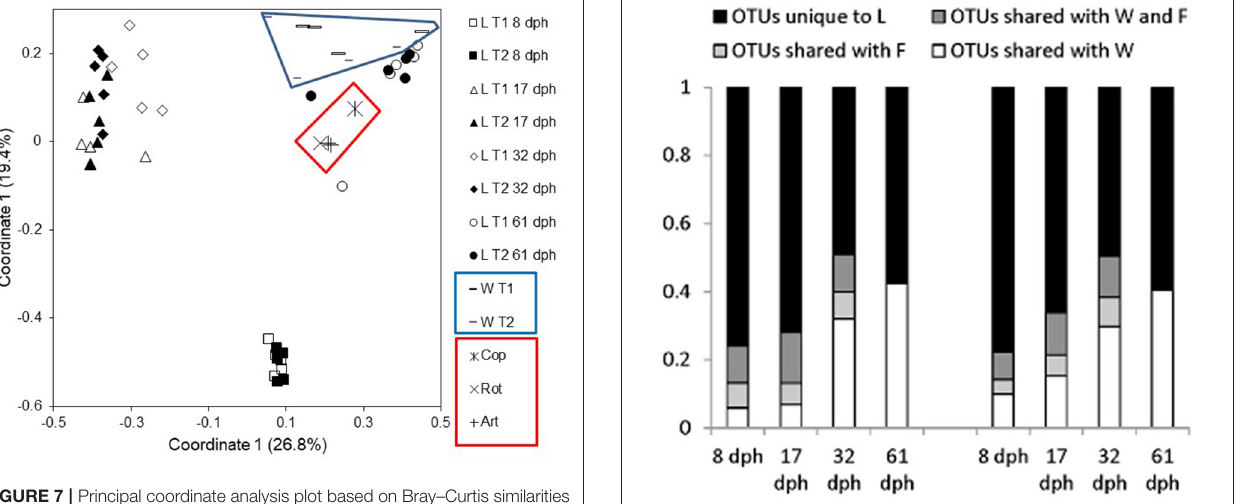
FIGURE 7 | Principal coordinate analysis plot based on Bray–Curtis similarities for comparison of microbiota from larvae (L), rearing water (W), copepod (Cop), rotifer (Rot), and Artemia (Art) samples from Tank 1 (T1; fed copepods) and Tank 2 (T2; fed rotifers). Modified from Bakke et al. (2015). Reproduced with permission from John Wiley and Sons.